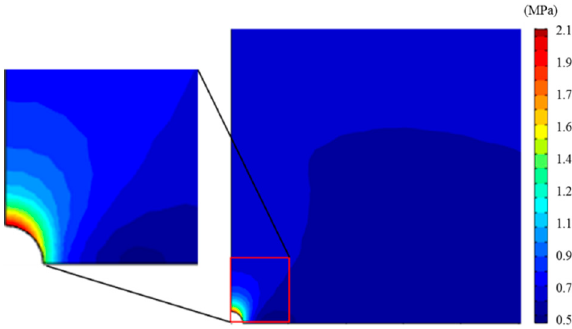
Figure 14. The distribution of shear stress of a hydrate-bearing near-wellbore reservoir.